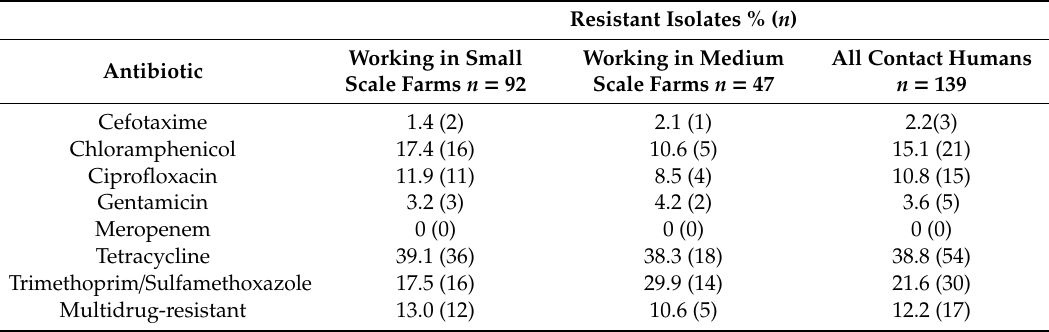
Table 2. Percentages and numbers of E. coli isolates resistant to antibiotics from farmworkers handling pigs (contact humans) in small- and medium-scaled farms in North-Eastern Thailand.